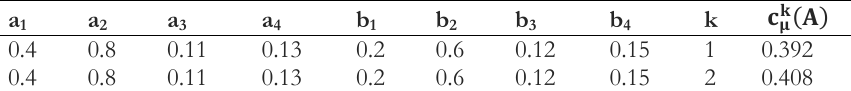
Table 1. Calculation of 𝐜 𝛍𝐤 (𝐀).